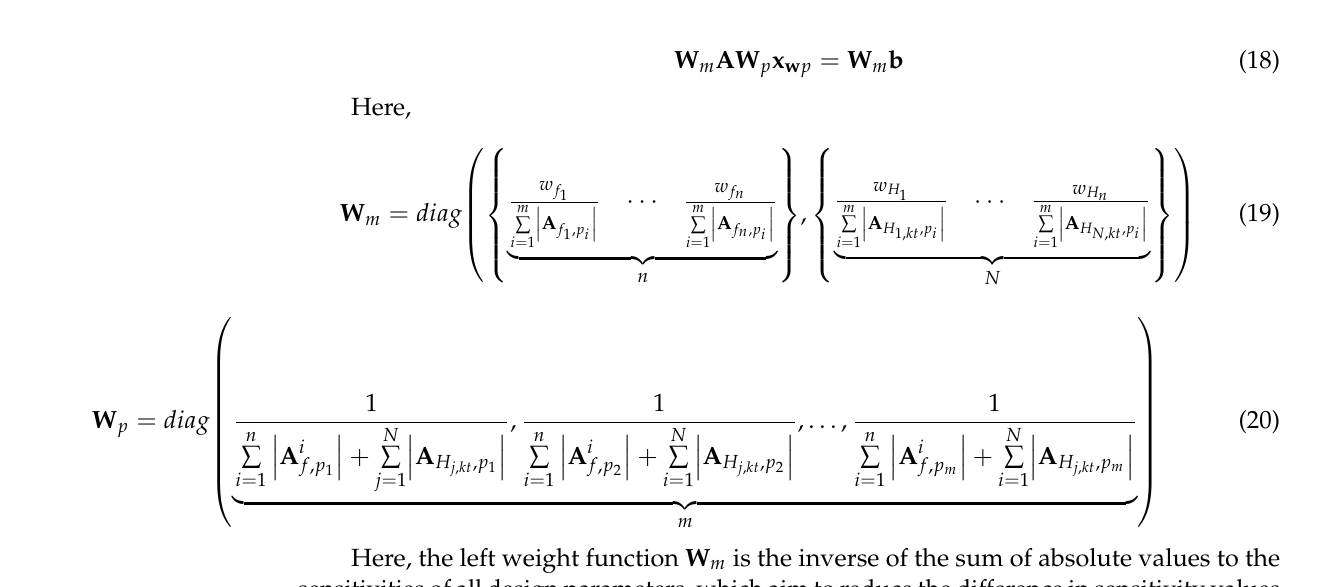
Table 6. Material parameters of